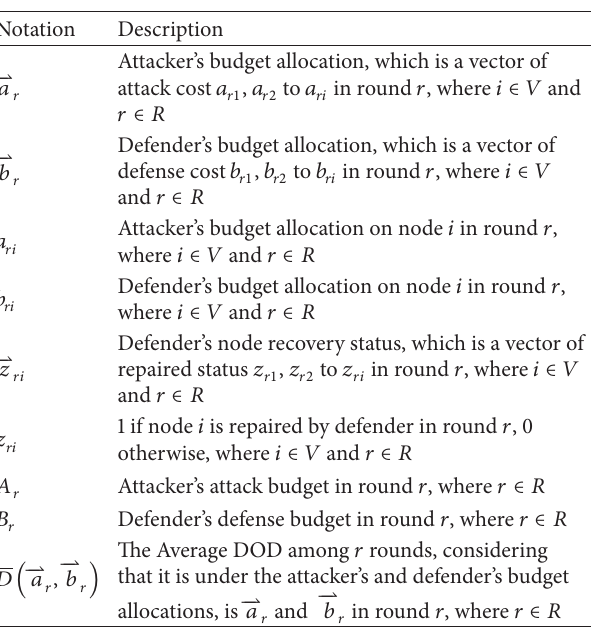
Table 5: Decision